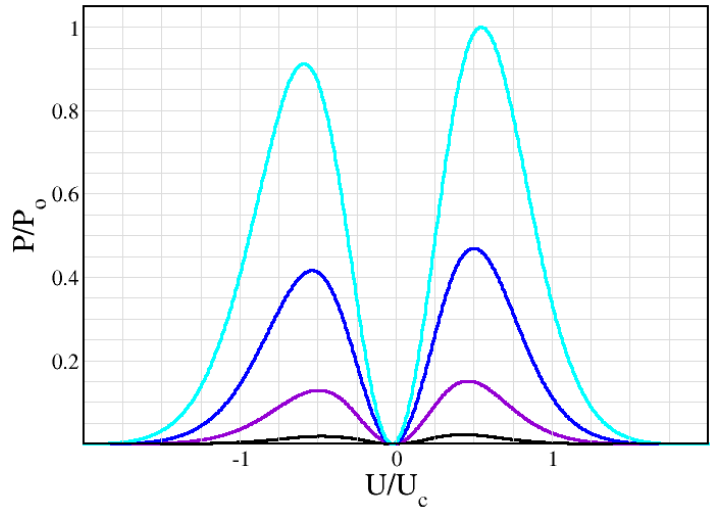
Figure 2. Second Harmonic power output for different values of the power control parameter, with an input frequency ν = 120 GHz. From bottom to top, α = 10, 16.7, 23.3 and 30, corresponding to black, violet, blue and cyan curves. The current flow asymmetry for all curves is δ = 0.91. U c is the same as in Figure 1 and P 0 is the maximum for α = 30.